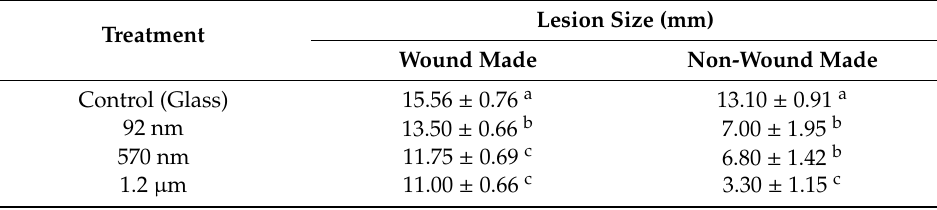
Table 2. Efficacy of different Ag particle samples for anthracnose treatment of mango. Table 2. E ffi cacy of di ff erent Ag particle samples for anthracnose treatment of